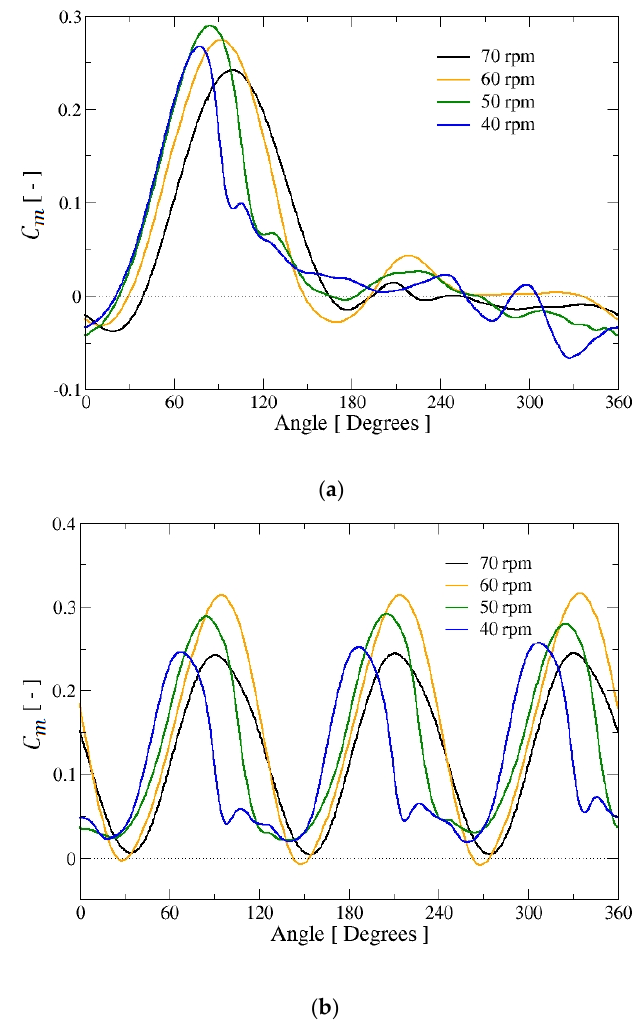
Figure 5. Torque coefficient evolution along a revolution for different values of λ . ( a ) Single blade and ( b ) three blades.